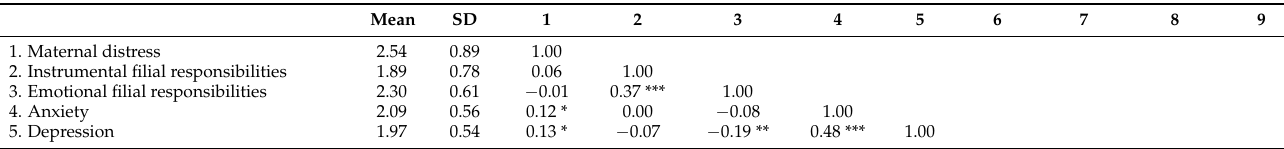
Table 1. Correlations of the measuring